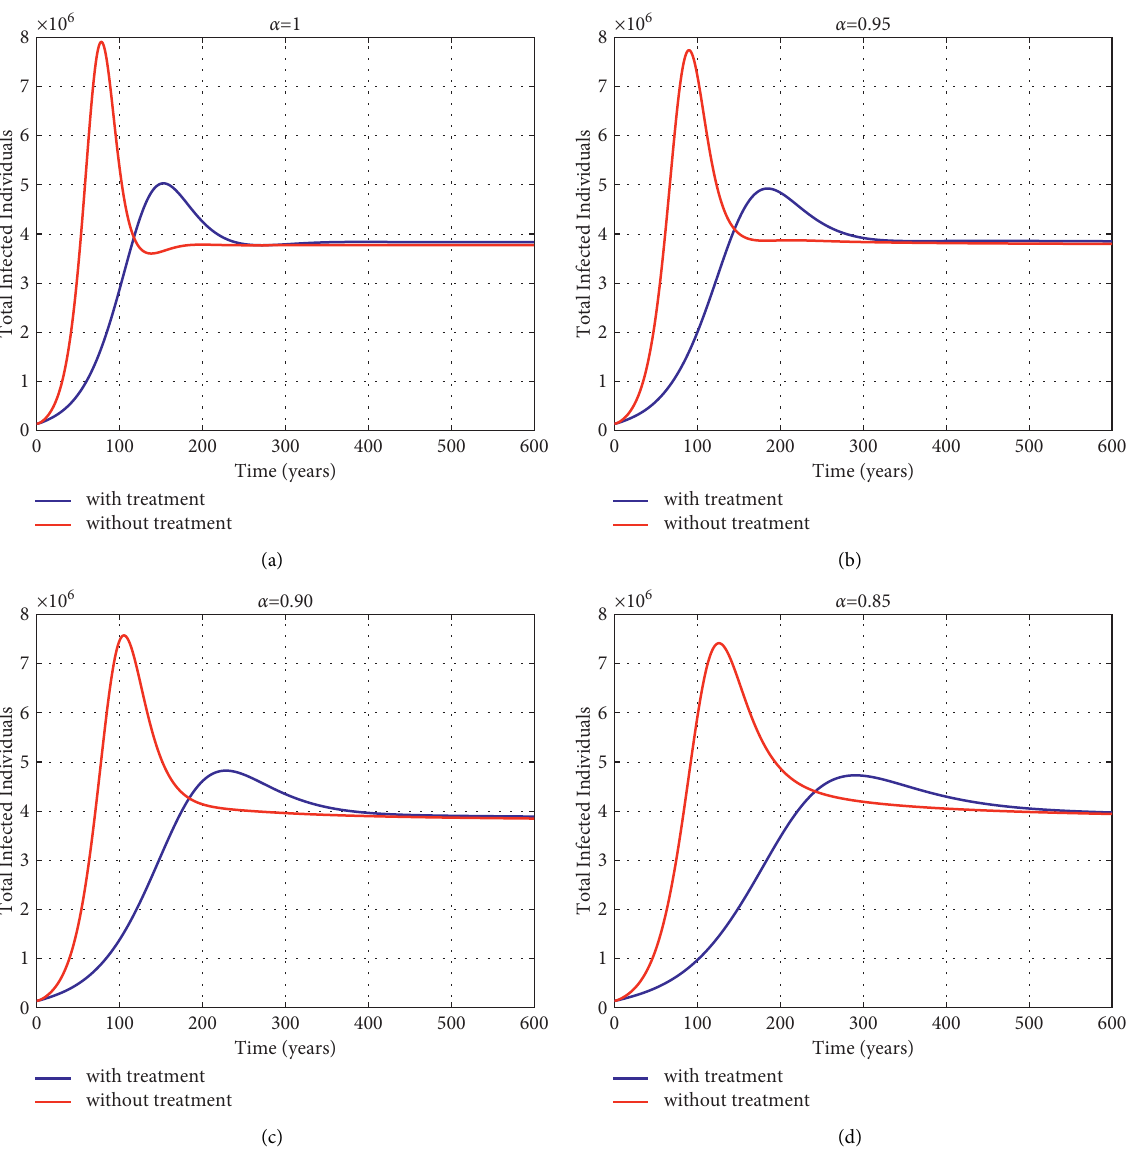
Figure 7: Behavior with and without treatment on total infected individuals for α � 1 , 0 . 95 , 0 . 90 , 0 .